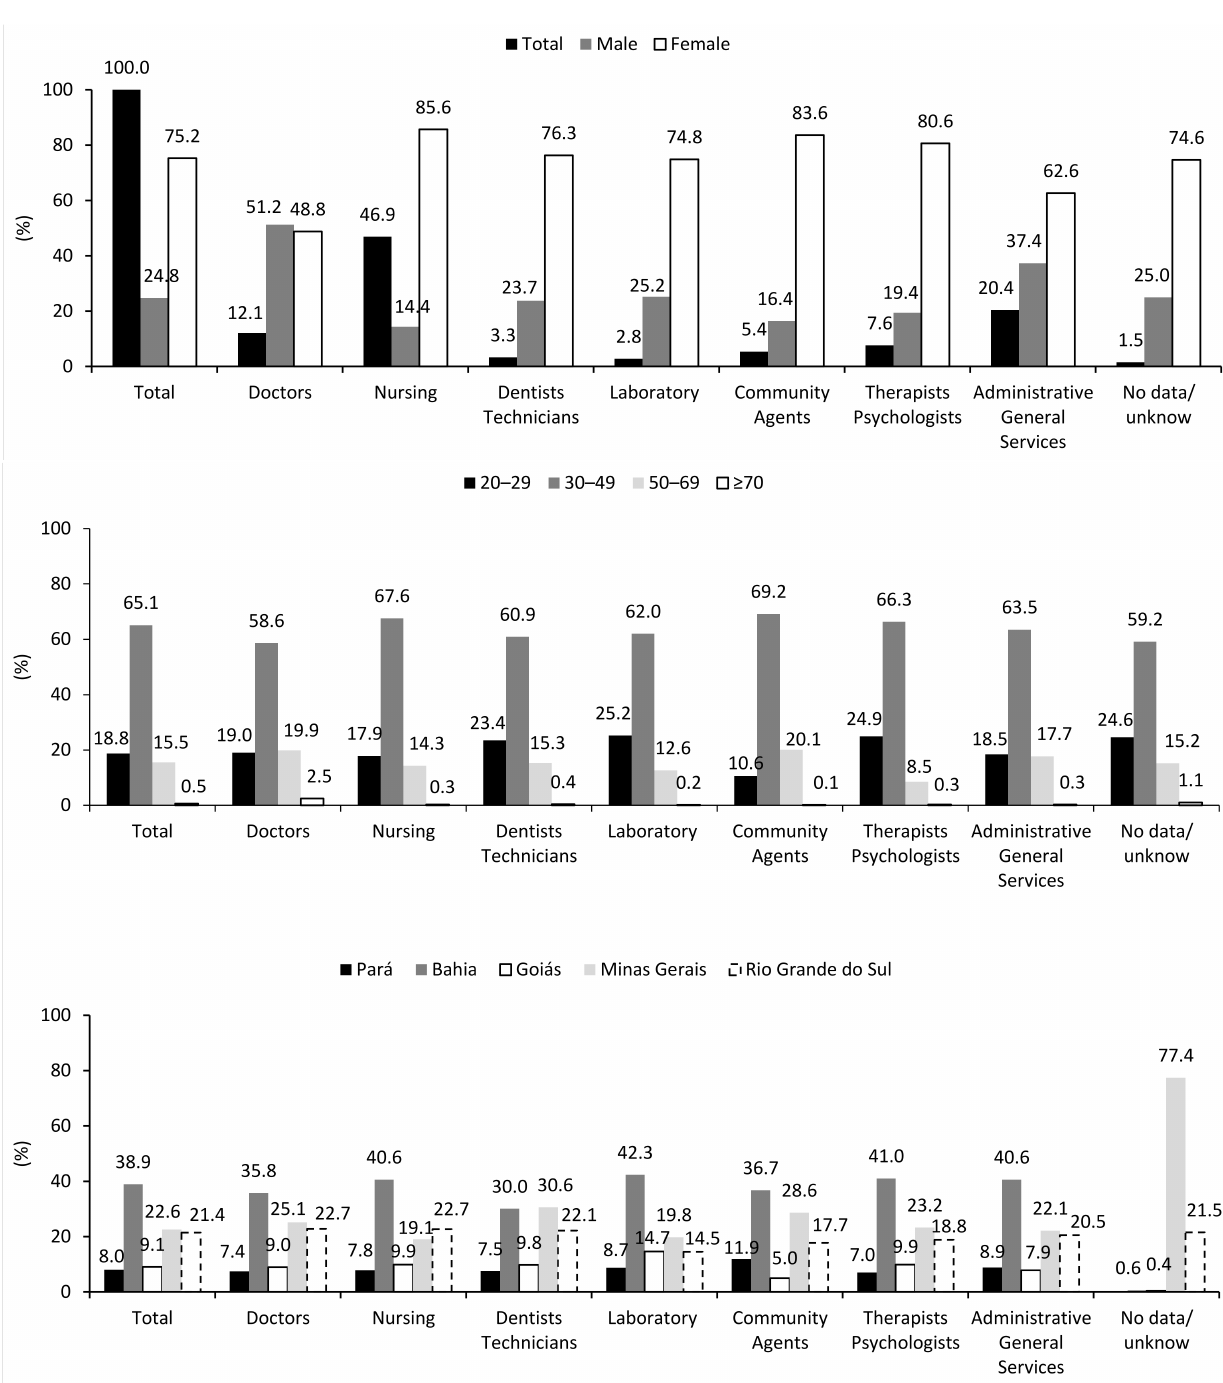
Figure 2. Relative distribution of occupation of health professionals notified as cases of flu-like syndrome in Brazil a , according to sex, age group, and states. DATASUS, e-SUS Notifica. a It is equivalent to the total number of cases in the largest states of the country, considering the number of municipalities. The data updated until 27 June 2020. Note 1: percentage was estimated considering the total (N = 186,044) of reported cases. Note 2: the total of missing or unknown data for the sex variable among health professionals was 11 cases. Therefore, for the sex variable, N =